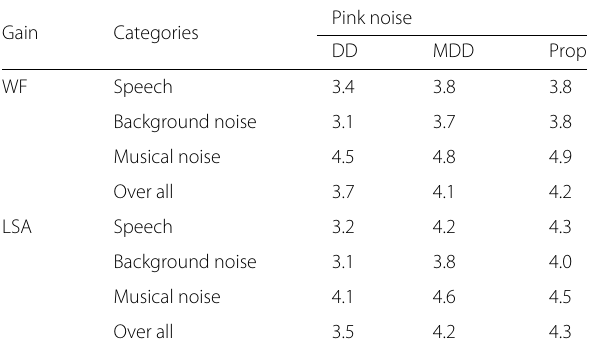
Table 12 Listening test results for babble noise at 10 dB input SNR